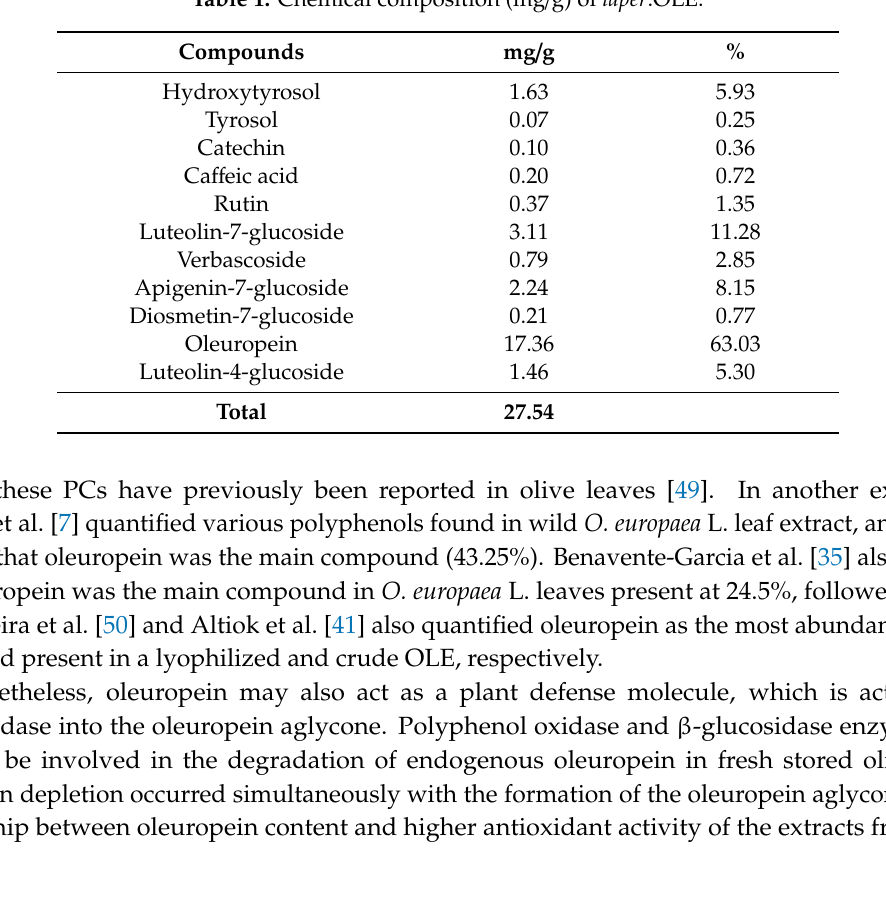
Table 1. Chemical composition (mg / g) of laper